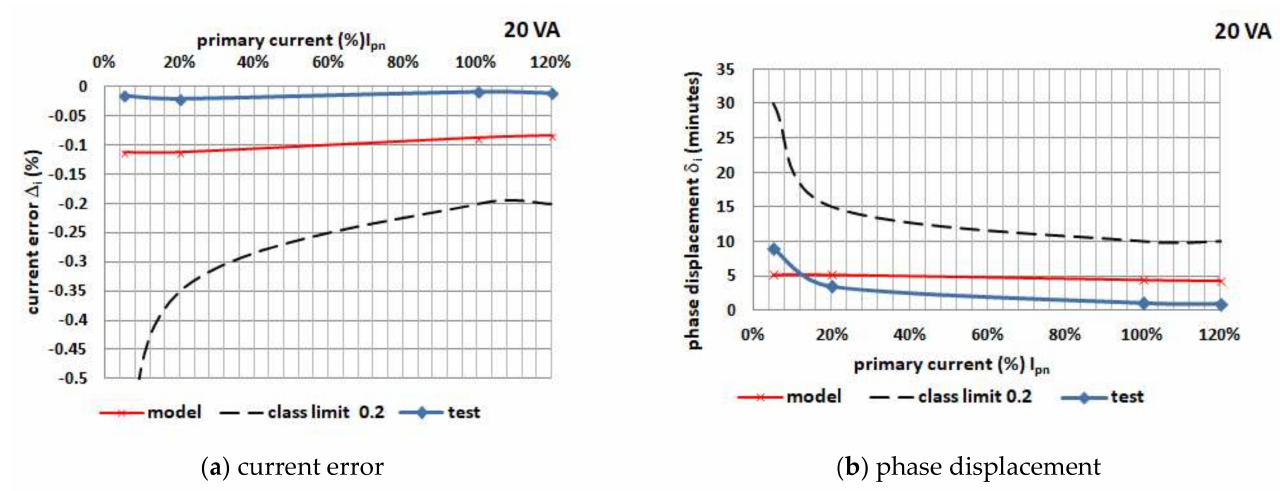
Figure 4. A comparison of the characteristics of the current error (a) and phase displacement (b) from calculations and tests for short-circuit transformers 50 kA/5